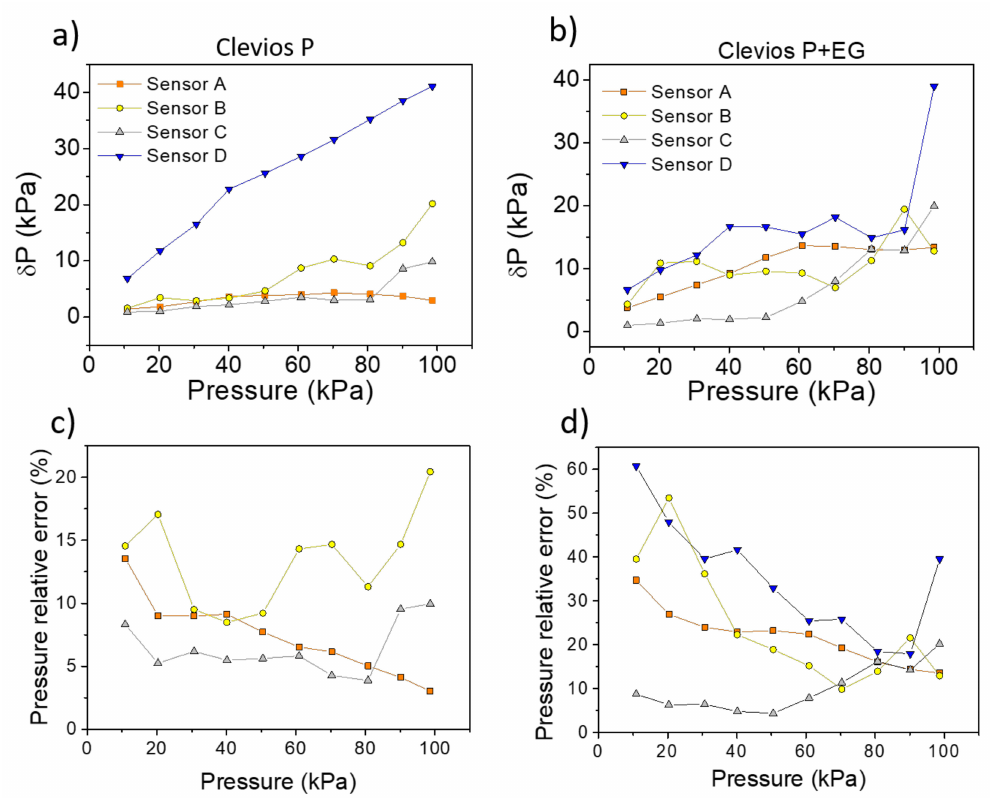
Figure 7. Pressure uncertainty values against the applied pressure ( a , b ). Here, for the sake of clarity, are reported the δ P values only every 10 kPa. The inset in ( a) also shows the trend of sensor D for the solution without ethylene glycol. The figures ( c , d ) report the pressure relative error for each sensor and for both formulations (excluding the sensor D with pristine